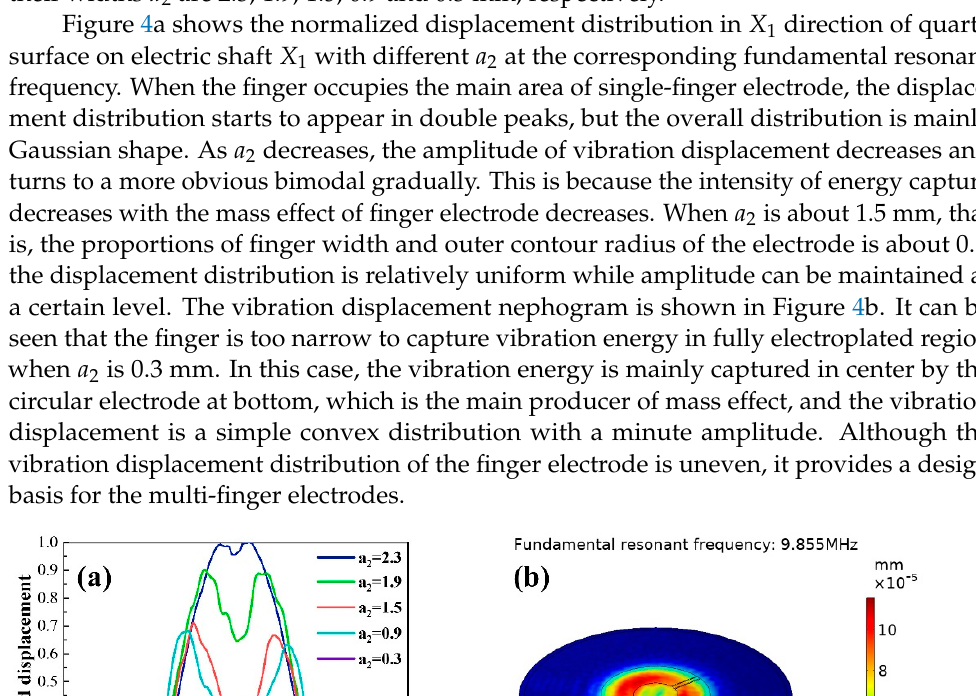
Figure 3. The finite element model of QCM with dot finger electrode.